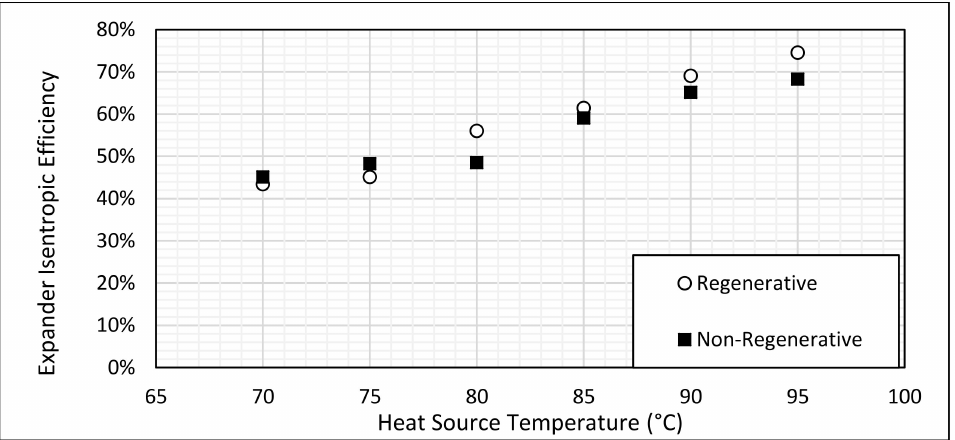
Figure 15. Variation of expander isentropic e ffi ciency with changing heat source temperature for the regenerative and non-regenerative